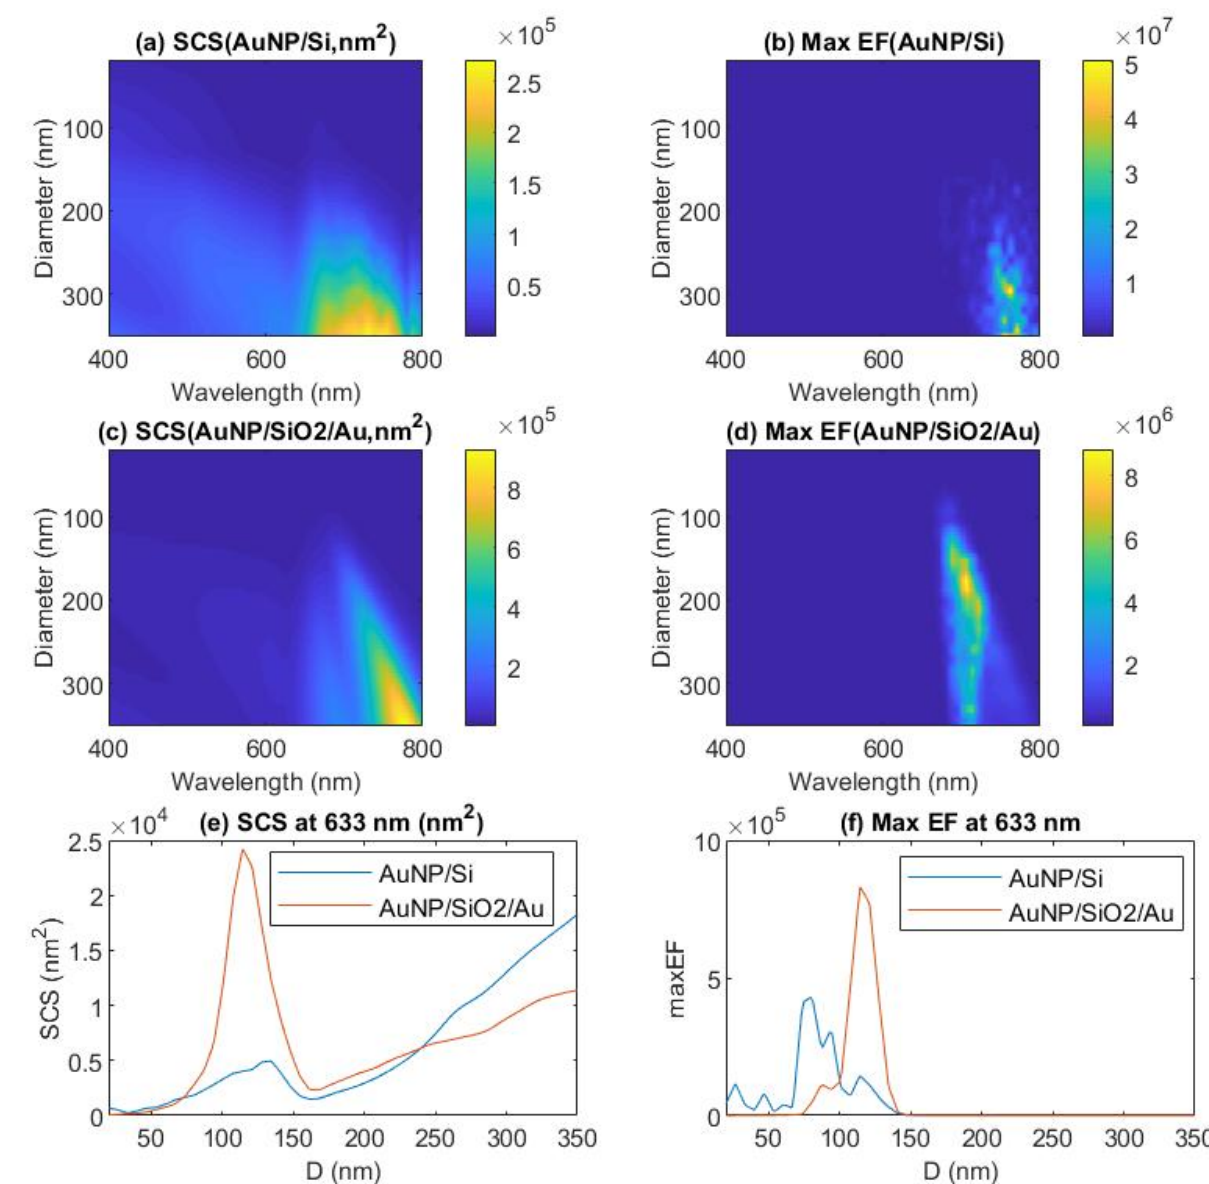
Figure 5. FDTD simulation of single sphere gold nanoparticle on a silicon substrate (AuNP/Si) and single sphere gold nanoparticle on silicon dioxide interception layer (10 nm) over a gold mirror (100 nm) on a sapphire substrate (AuNP/SiO 2 /Au/Sapphire). ( a ) Scattering cross section of a single sphere gold nanoparticle for model (AuNP/Si) depends on sphere diameter and incident wavelength. ( b ) Maximum enhancement factor (/E/ \ /E 0 /) 4 of a single sphere gold nanoparticle for model (AuNP/Si) depends on sphere diameter and incident wavelength. ( c ) Scattering cross section of a single sphere gold nanoparticle for model (AuNP/SiO 2 /Au/Sapphire) depends on sphere diameter and incident wavelength. ( d ) Maximum enhancement factor (/E/ \ /E 0 /) 4 of a single sphere gold nanoparticle for model (AuNP/SiO 2 /Au/Sapphire) depends on sphere diameter and incident wavelength. ( e ) Scattering cross section of a single sphere gold nanoparticle for model (AuNP/Si) and model (AuNP/SiO 2 /Au/Sapphire) depends on sphere diameter at an incident wavelength of 633 nm. ( f ) Maximum enhancement factor (/E/ \ /E 0 /) 4 of a single sphere gold nanoparticle for model AuNP/Si and model AuNP/SiO 2 /Au/Sapphire depends on sphere diameter at an incident wavelength of 633 nm.